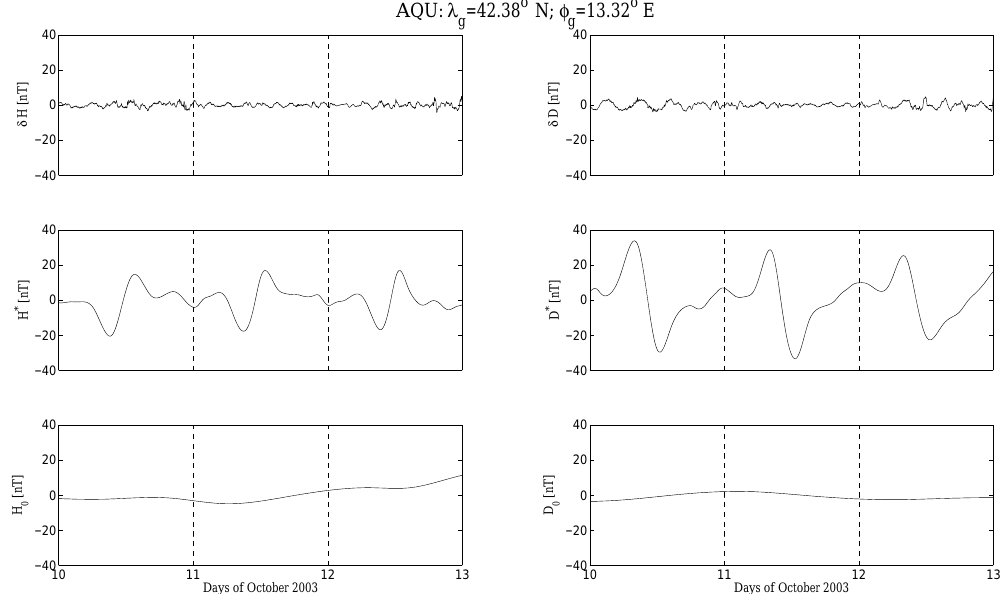
Figure 4. SSQ, 10–12 October 2003: EMD reconstruction for the H (left panels) and D (right panels) components at midlatitude ground station (AQU: λ g = 42 . 38 ◦ N and φ g = 13 . 32 ◦ E). The time resolution is 1min.